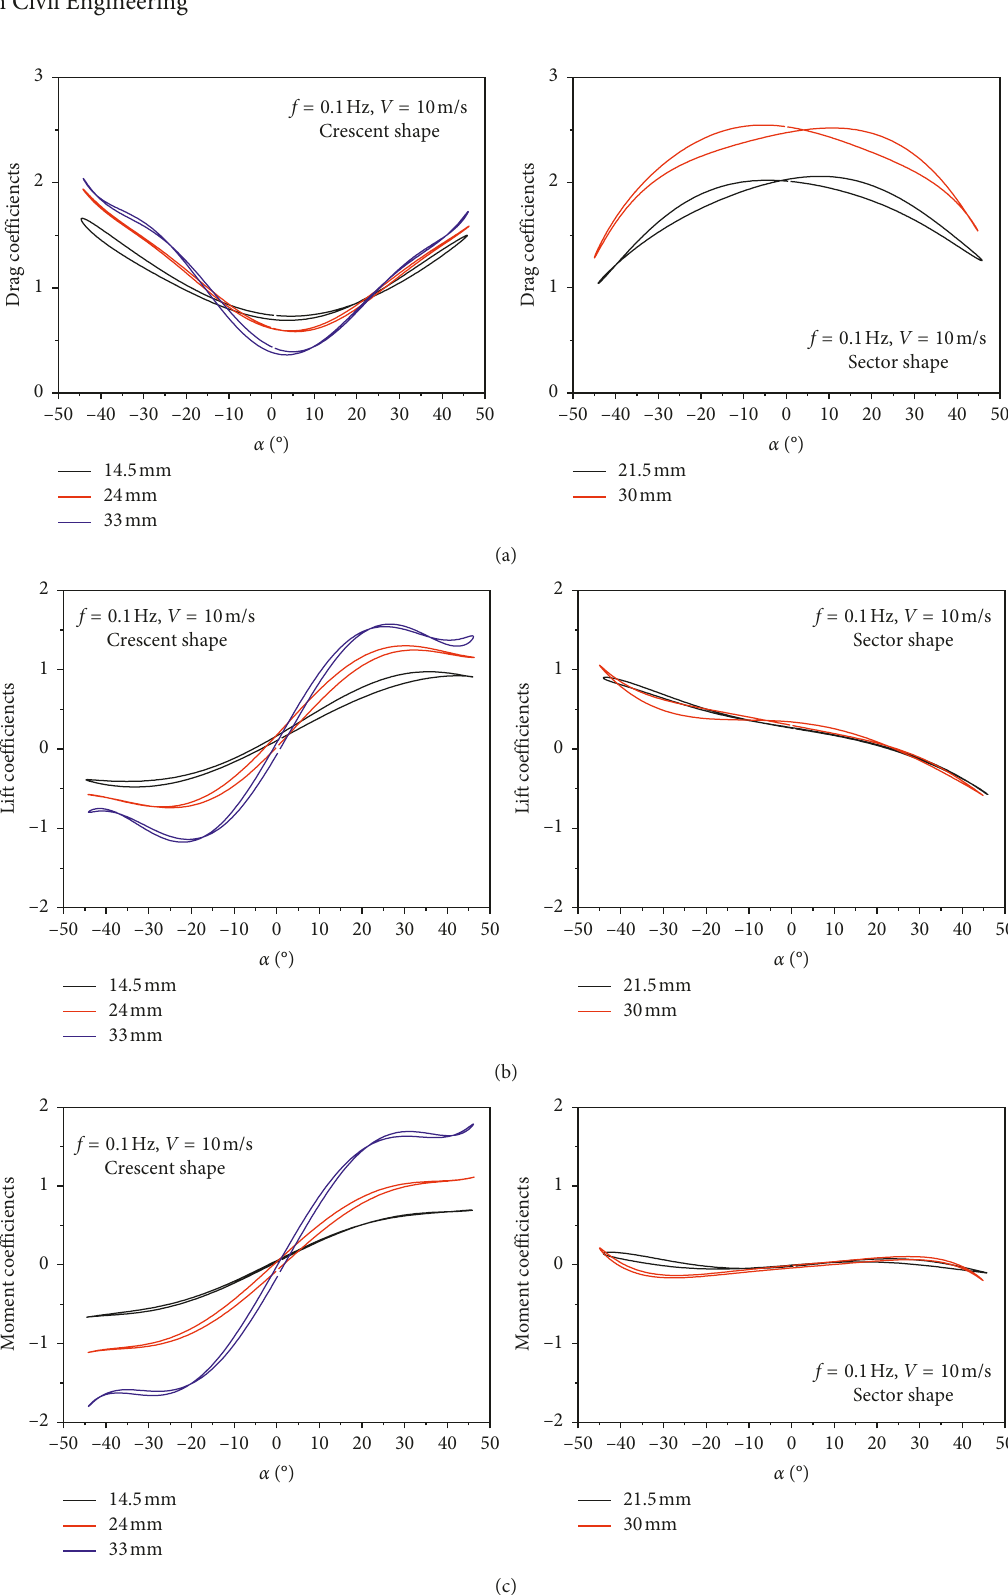
Figure 9: The unsteady aerodynamic coefficients of sector-shape iced subconductor 1 under different ice thickness: (a) drag coefficients; (b) lift coefficients; (c) moment